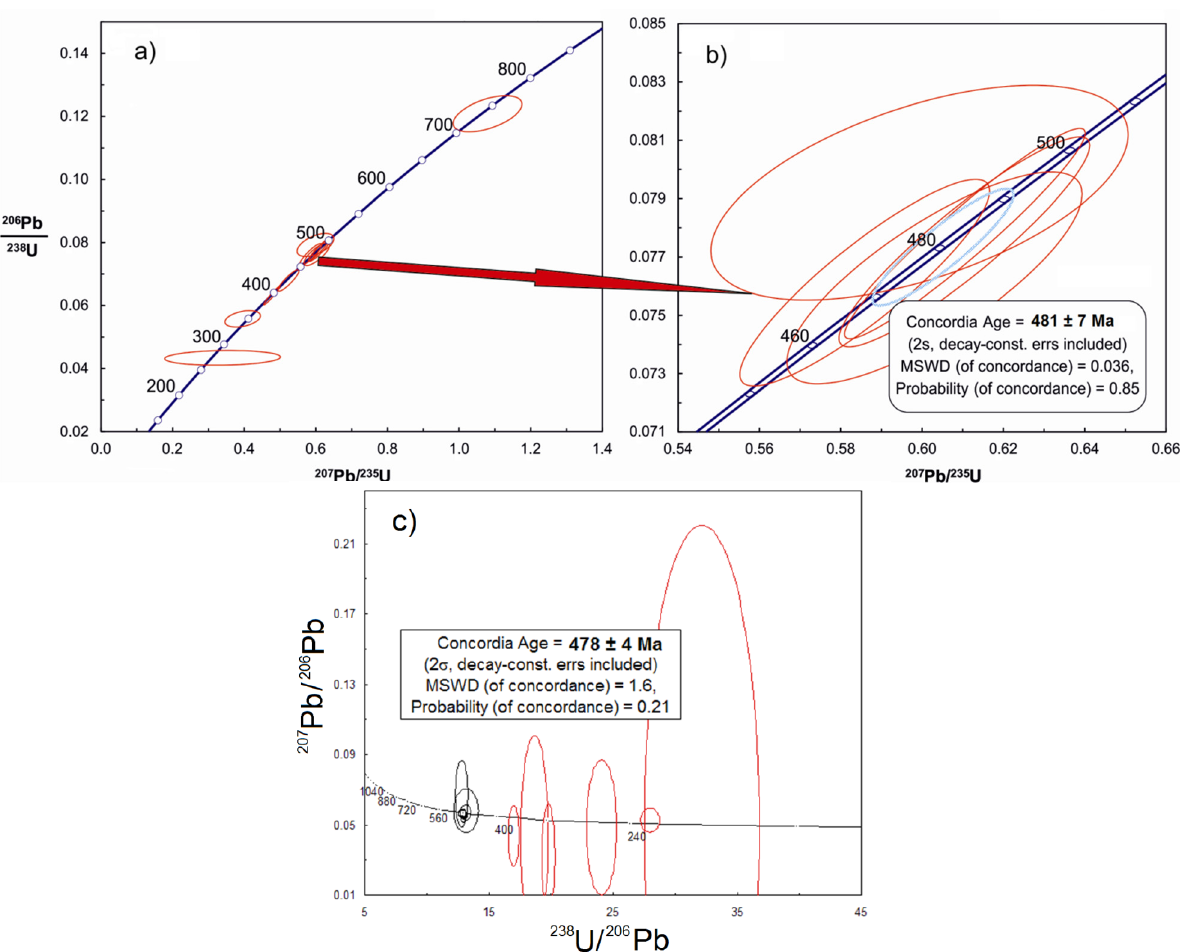
Figure 5. ( a , b ) Concordia diagram for zircons from sample 108-B of the leucogranite; ( c ) Tera–Wasserburg concordia diagram for zircons (sample DV-27/04) from biotite granite of the Voznesensky complex.